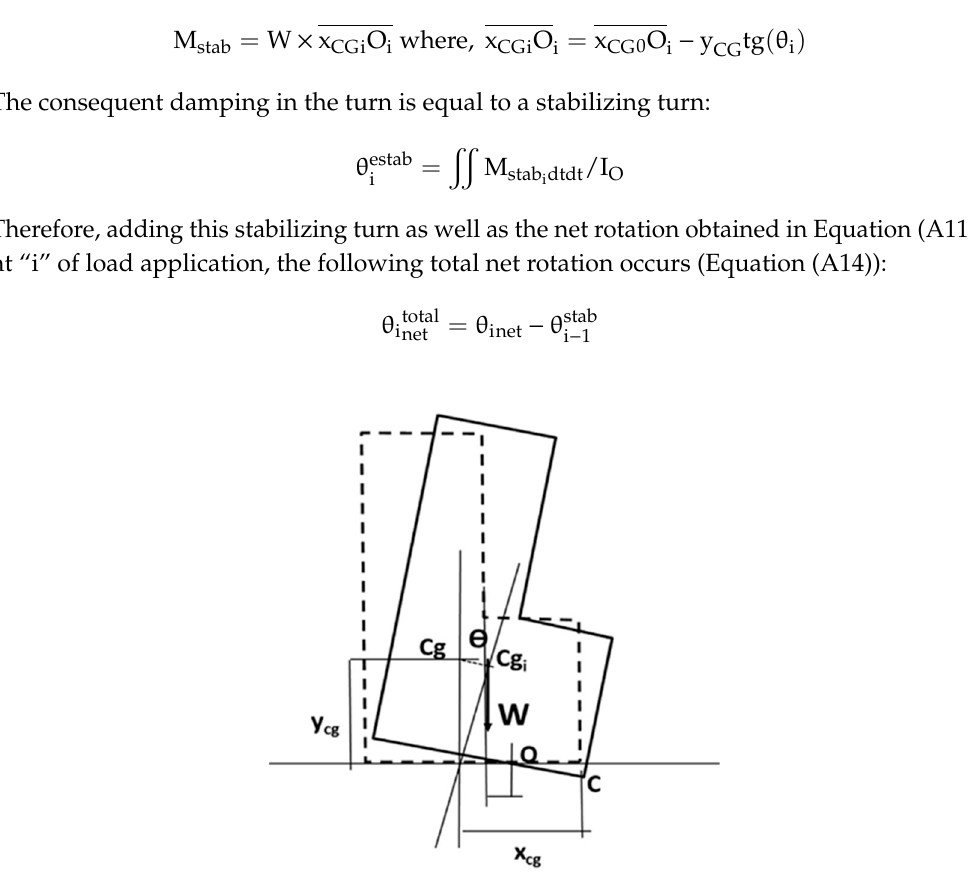
Figure A5. Damping of the rotation as a result of the stabilizing moment.